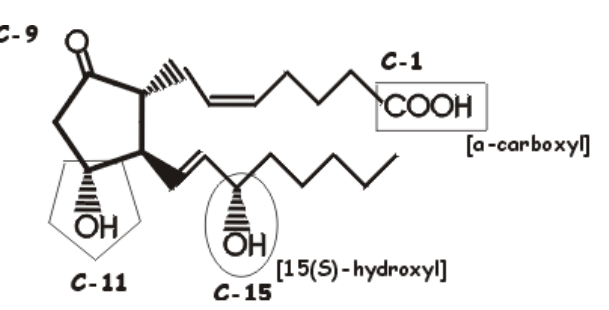
FIGURE 2 . Structure of prostaglandin E 2